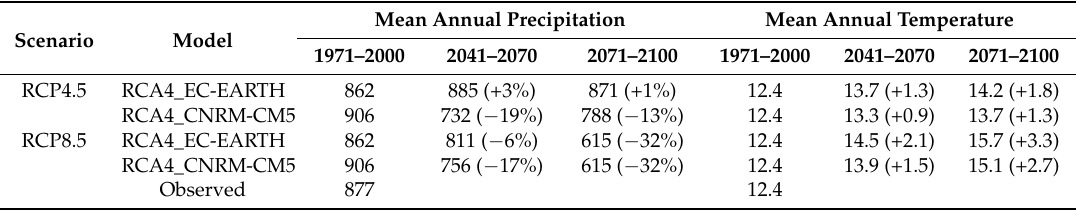
Table 7. Precipitation (mm) and temperature ( ◦ C) means with their